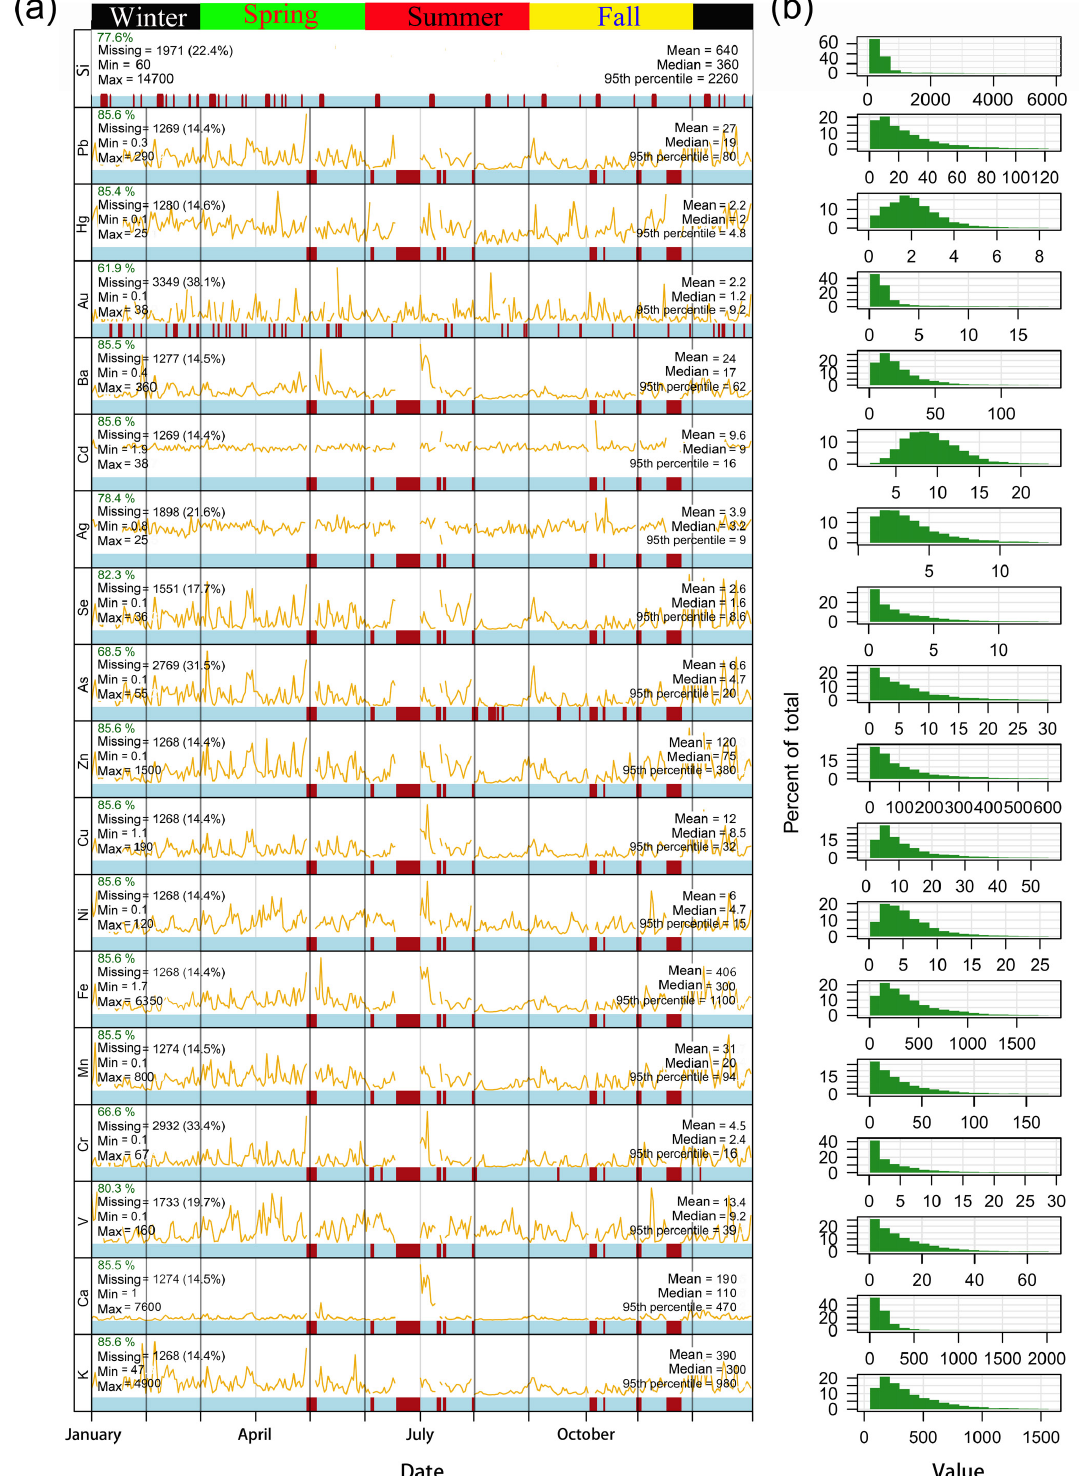
Figure 2. General statistical summary of 18 trace elements measured in Shanghai. The plots in panel (a) show the time series data, where blue shows the presence of data and red shows missing data. The mean daily values are shown in pale yellow, scaled to cover the range in the data from zero to the maximum daily value. As such, the daily values are indicative of an overall trend rather than conveying quantitative information. For each elemental species (at hourly resolution), the overall summary statistics are given. Panel (b) on the right shows the distribution of each elemental species using a histogram